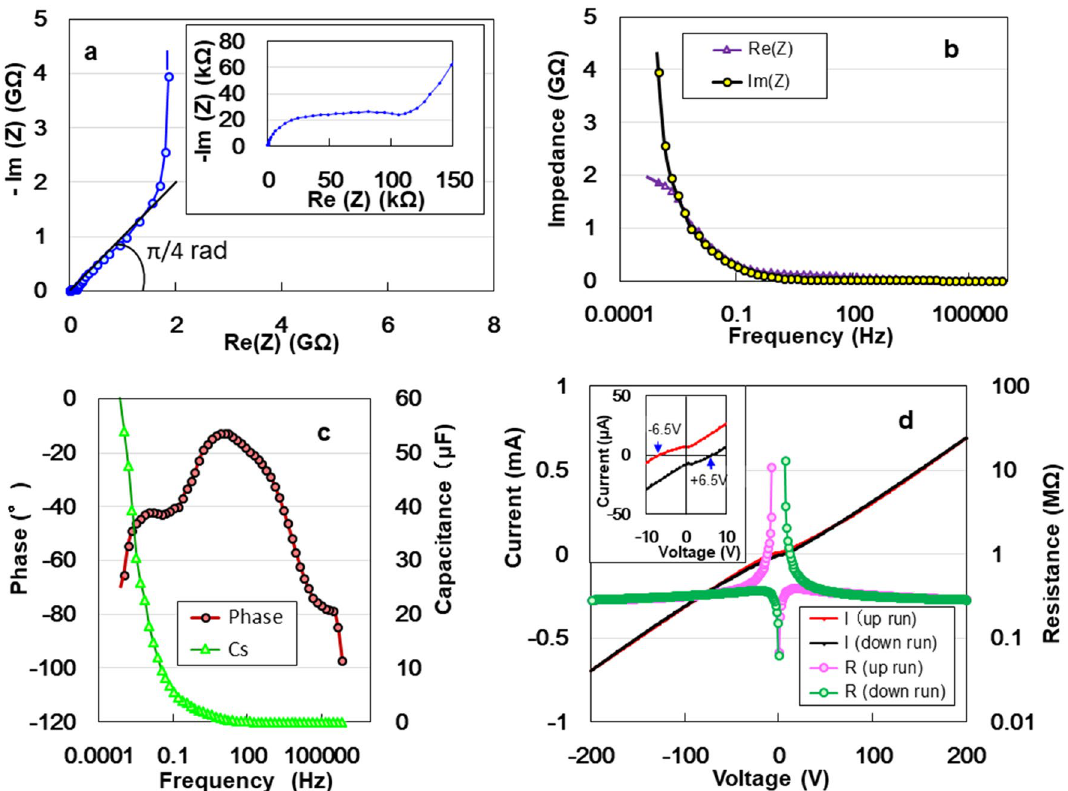
Figure 2. Non-destructive analysis of the electrostatic contribution of the specimen. ( a ) Nyquist plot as a function of frequency for the ACF device. ( b ) Real and imaginary impedances. ( c ) Frequency dependence of phase angle and series capacitance. ( d ) I–V and R–V characteristics between − 200 and + 200